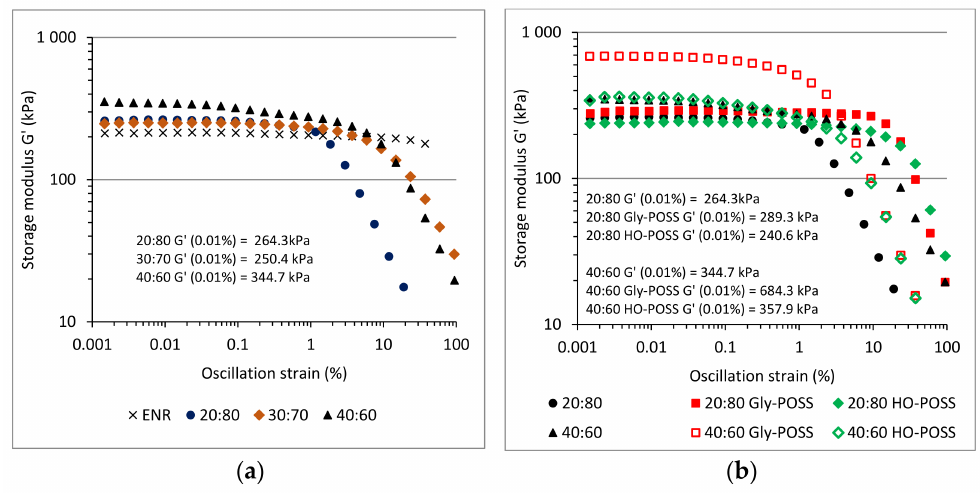
Figure 7. Storage shear modulus G’ as a function of oscillation strain at angular frequency of 10 rad s − 1 (1.59 Hz) at 30 ◦ C for ENR/PLA ( a ) and POSS modified blends ( b